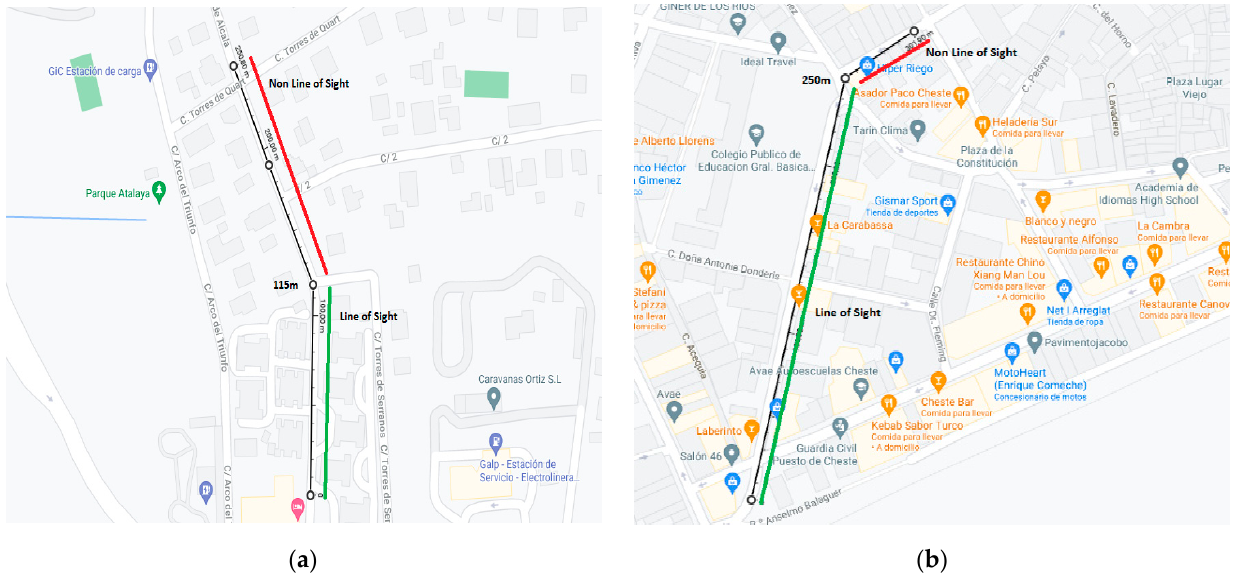
Figure 7. Diagram of the environments used for Smart City—I2P. ( a ) Residential area, ( b ) Urban area.